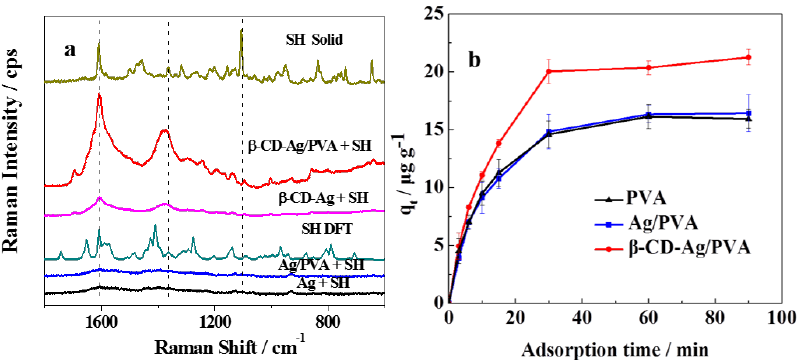
Figure 2. ( a ) Comparison of the SERS performance for SH detection with different substrates; ( b ) Adsorption kinetics of SH on PVA, Ag/PVA and β-CD-Ag/PVA (298 K).